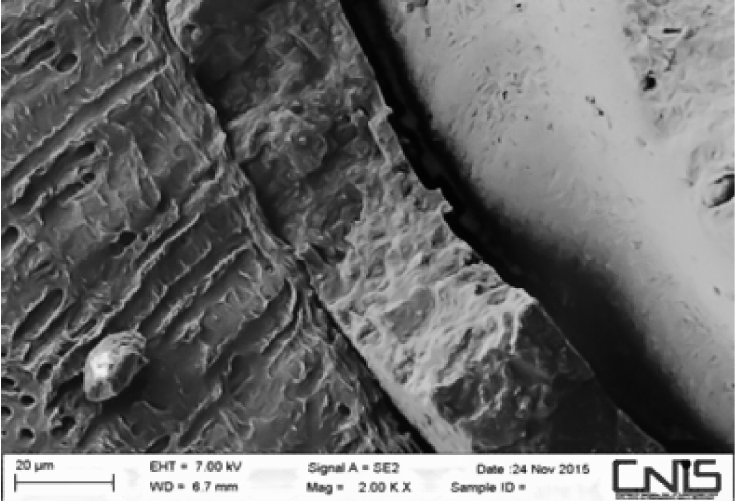
Figure 9. Interface between dentin and sealant. Section of the second medium third G system.